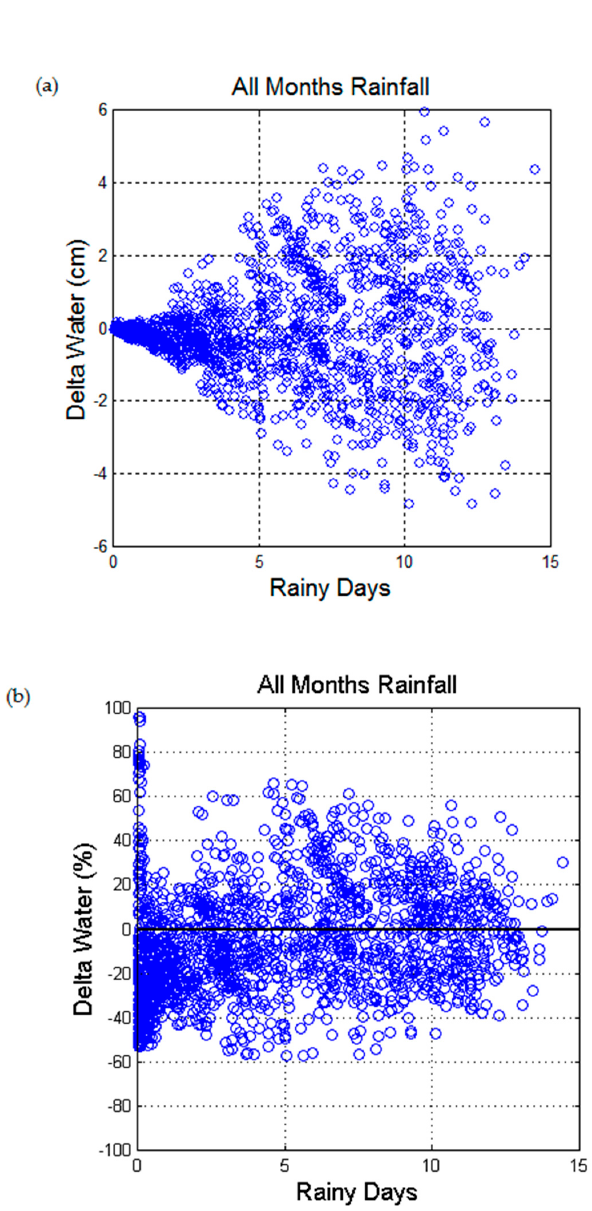
Figure 11. (a): scatterplot of the difference between the monthly average quantity of precipitated water of Figure 10 and the regression curve (10), named Delta Water, and the average number of monthly rainy days concerning 184 localities of the Holy Land, for each month in the years from 1990 to 2015. (b): scatterplot of the same quantities but with the difference given in percent (%) of the value of the parabolic regression curve (10).